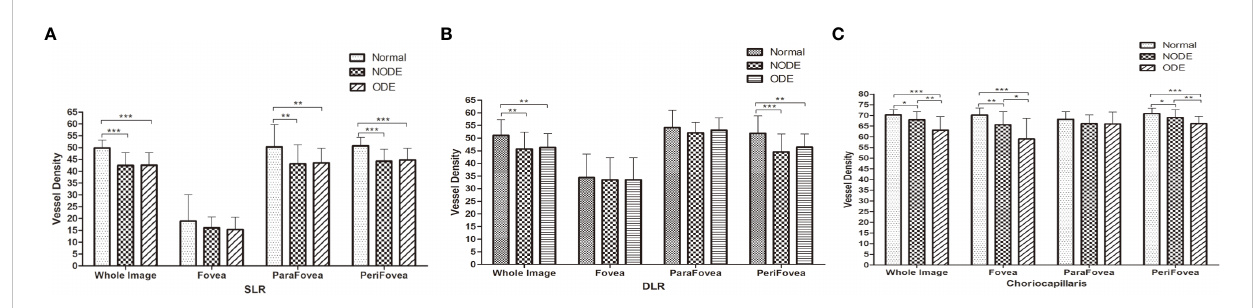
FIGURE 3 Macular VD of SLR, DLR and CC in different groups were listed in (A) , (B) and (C) respectively. Compared with normal group, there is a signi fi cant decreased in VD of macular CC and retina in NODE and ODE group. The VD of macular CC in ODE group was signi fi cantly reduced than that of NODE group, while not in macular retina. SLR, super fi cial layer; DLR, deep layer; CC, choriocapillaris. (* indicates p<0.05, ** indicates p<0.01 and ***indicates